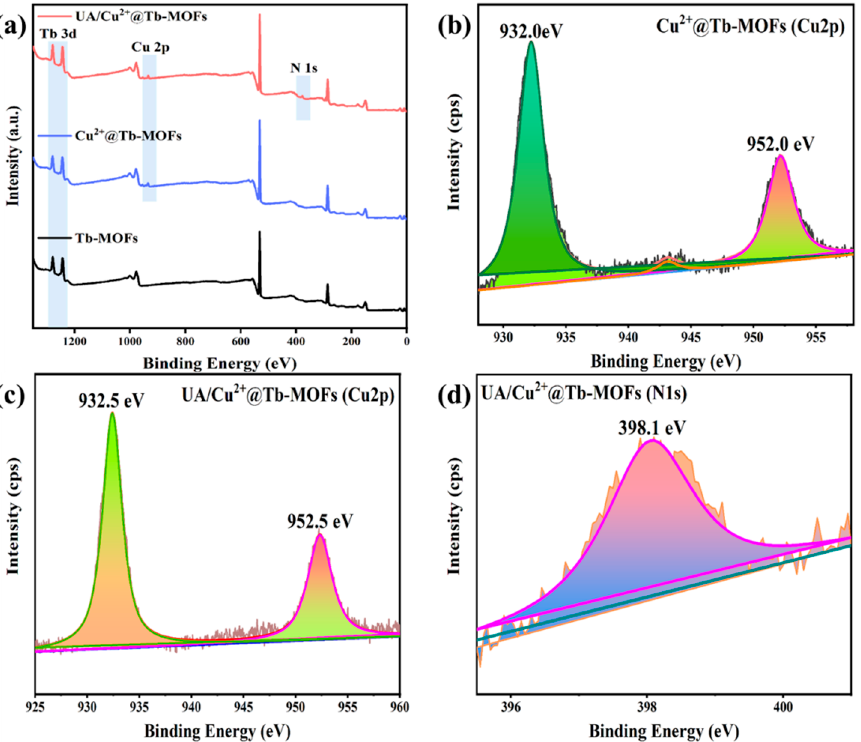
Figure 4. ( a ) The XPS spectra for Tb-MOFs, Cu 2+ @Tb-MOFs, UA/Cu 2+ @Tb-MOFs; ( b ) The XPS peaks of Cu 2+ in Cu 2+ @Tb-MOFs samples; ( c ) The XPS peaks of Cu 2+ in UA/Cu 2+ @Tb-MOFs samples; ( d ) The XPS peaks of N in UA/Cu 2+ @Tb-MOFs samples.